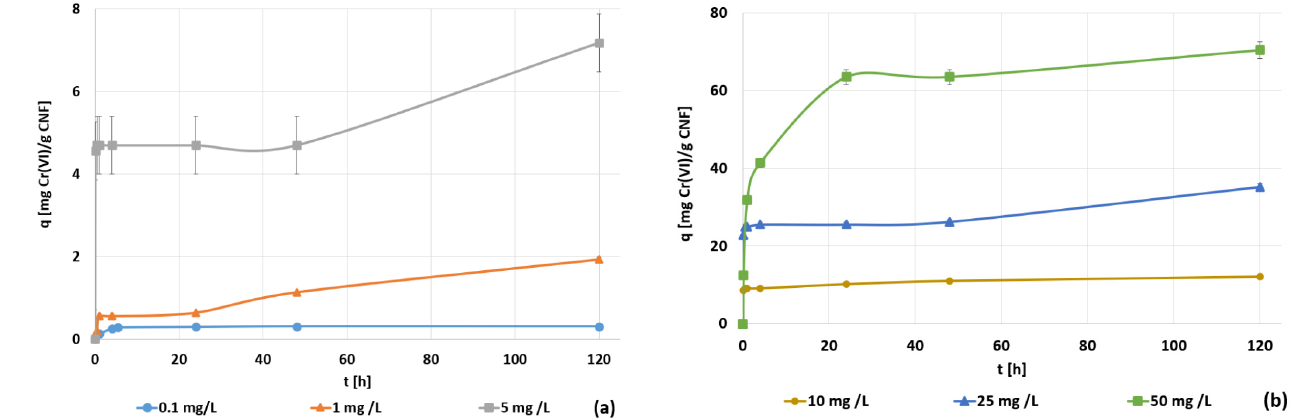
Figure 10. ( a ) The evolution of the hexavalent chromium concentration [mg·L − 1 ] during the adsorp- tion with CNF hydrogel at 1000 mg·L − 1 of dosage, 1.5 mmol MTMS·g − 1 CNF, and pH 3 conditions under 0.1 to 5 mg·L − 1 ; ( b ) 10 to 50 mg·L − 1 initial hexavalent chromium concentrations.